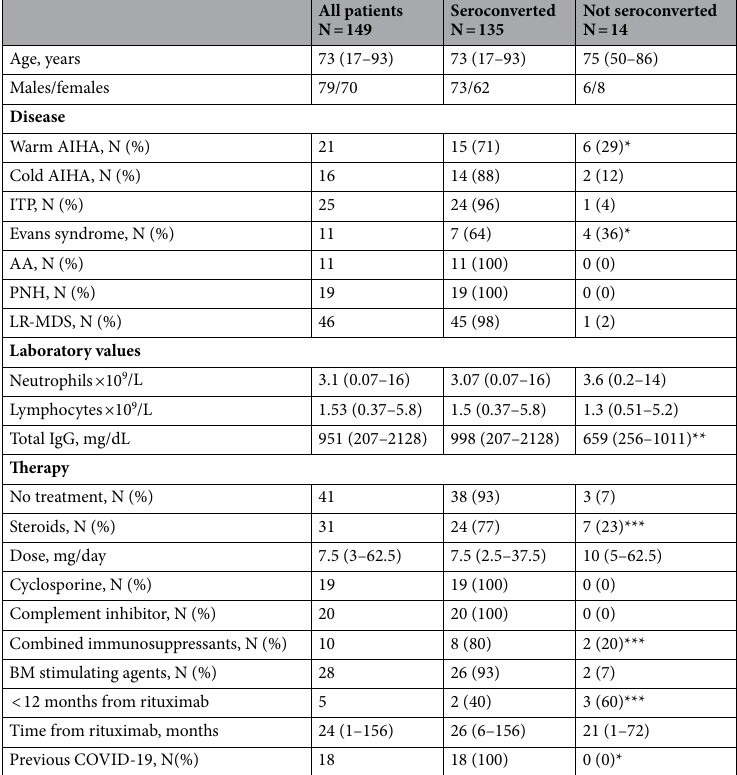
Table 1. Clinical and laboratory features of enrolled patients divided according to seroconversion status for anti-Spike antibodies. *p ≤ 0.001; **p = 0.005; ***p <